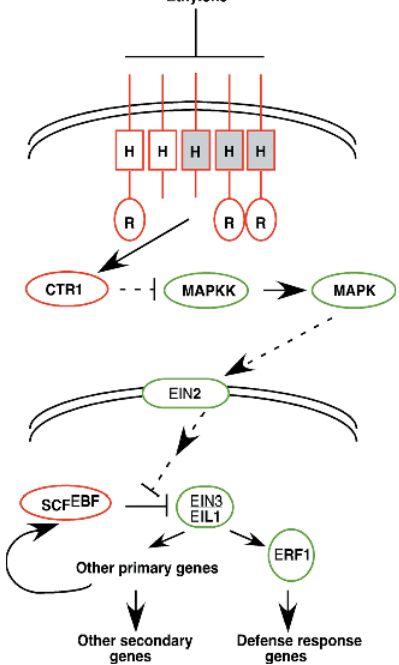
Figure 3. A Model for the Arabidopsis Ethylene Response Pathway Ethylene is perceived by a family of two-component receptors containing a consensus (unshaded) or degenerate (shaded) HK domain (H). Three of the receptors also contain a C-terminal receiver domain (R). The receptors negatively regulate ethylene response together with CTR1 in a complex on the endoplasmic reticulum membrane. Perception results in reduced receptor and CTR1 activities and activation of a MAP kinase kinase, which transmits the signal through the EIN2 membrane protein, ultimately resulting in the activation of a transcriptional cascade in the nucleus. The EIN3 and EIL1 transcription factors regulate primary response genes including ERF1 , which activates a subset of secondary ethylene- induced genes involved in defense responses. EIN3/EIL1 abundance is regulated in an ethylene-dependent manner by SCF complexes containing F-box proteins encoded by the ethylene- induced genes EBF1 and EBF2 . Positive- and negative-acting components of the pathway are indicated in green and red, respectively. Solid lines indicate regulation that is likely to be through direct interactions. Dotted lines indicate speculative interactions based on genetic